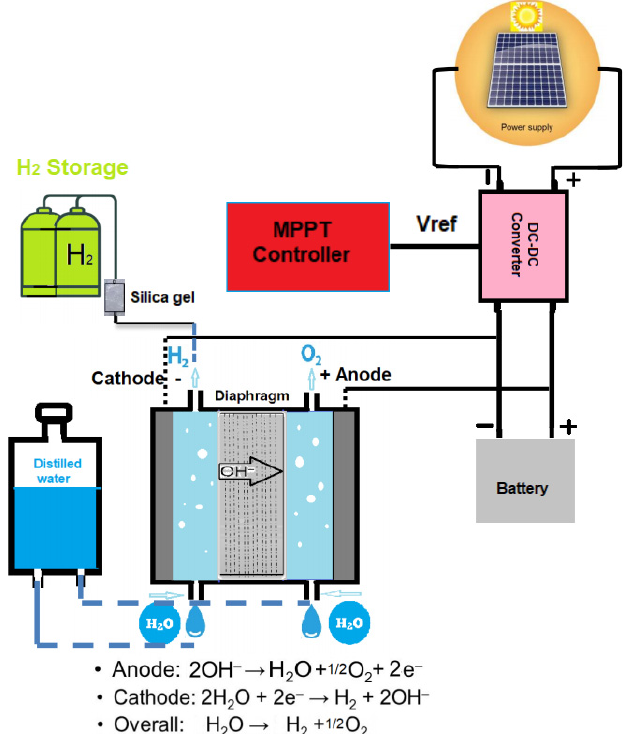
Figure 16. Photovoltaic system for hydrogen production.